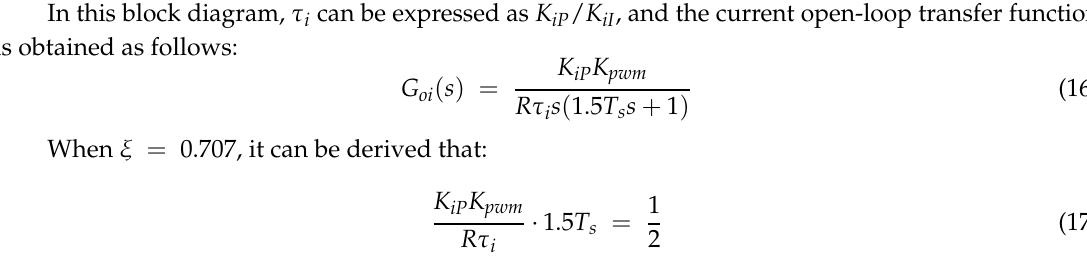
Figure 8. Simplified block diagram of current closed-loop control.